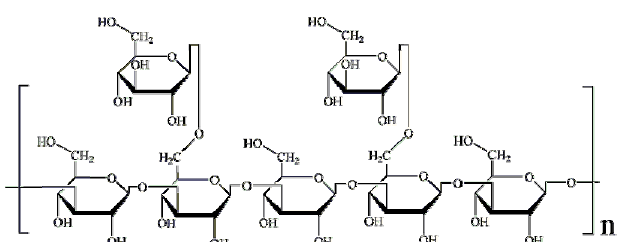
Figure 1. Chemical structure of